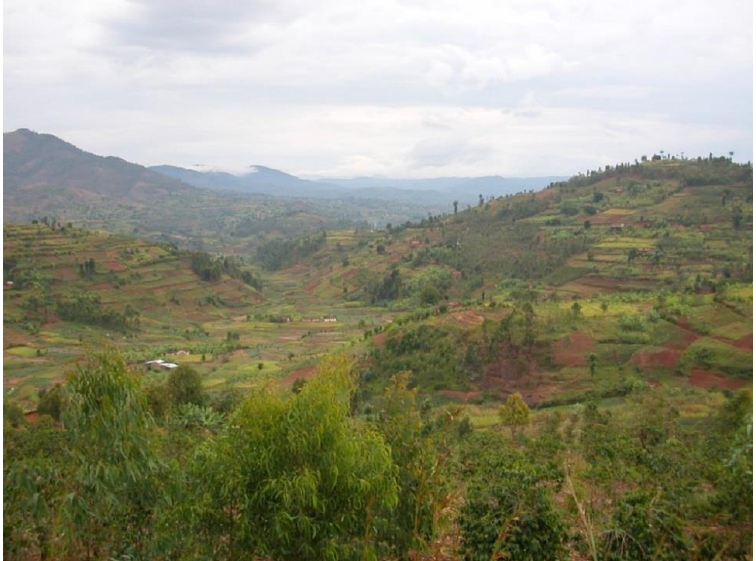
Figure 2. South facing image of a rural landscape showing steep-sided hills and small fragmented agricultural plots at approximately lat., −2.53, lon.,